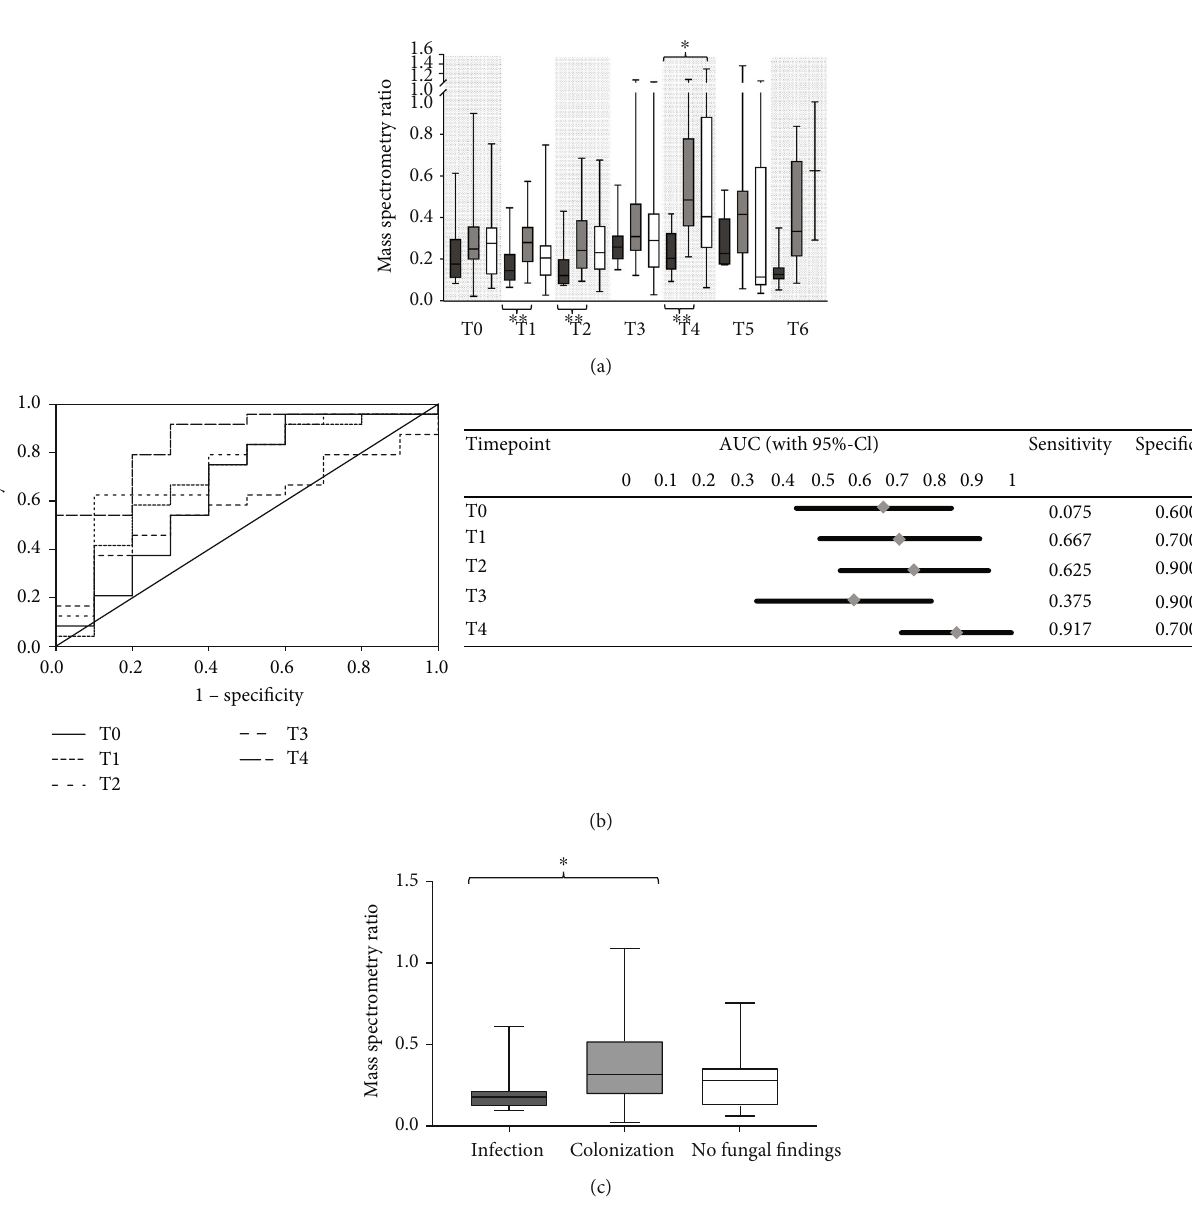
Figure 4: Plasma concentrations of vinculin for the detection of an IFI in patients with septic shock. (a) Plasma concentrations of vinculin were measured by mass spectrometry in patients su ff ering from septic shock with an invasive fungal infection (IFI, dark grey box), a fungal colonization (light grey box), or without any fungal fi ndings (white box). Plasma samples were collected at the onset of septic